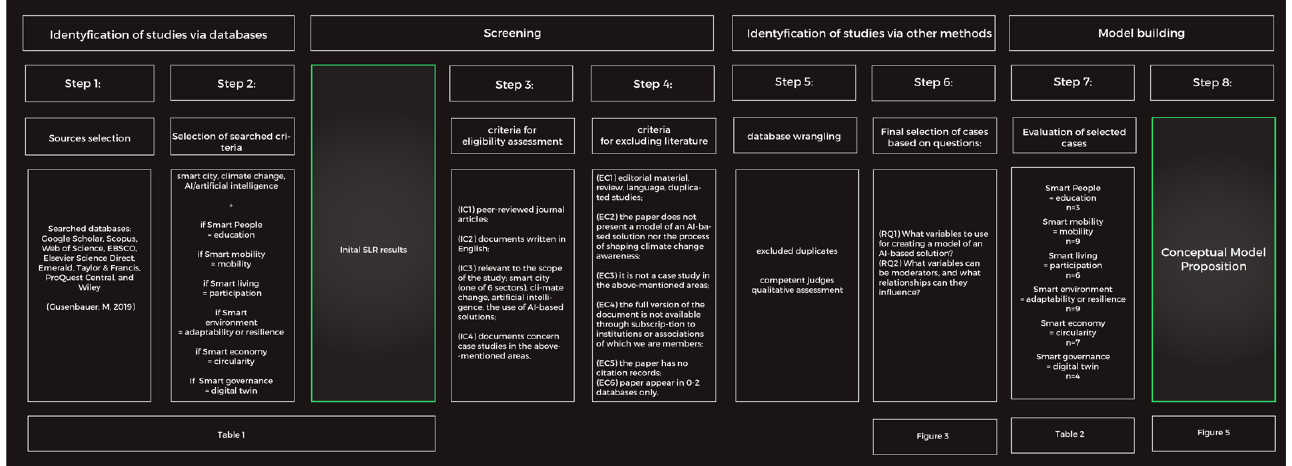
Figure 4. PRISMA application flowchart introducing the methodological approach (adapted from Yasin and Abbas [59] and Page et al. [11]).